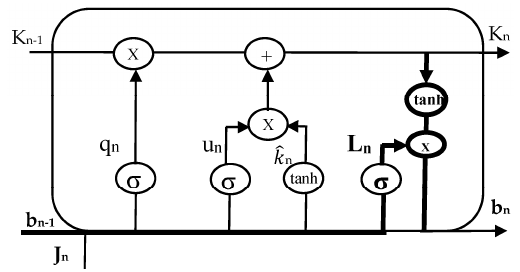
Figure 5. Output gate of LSTM cell.